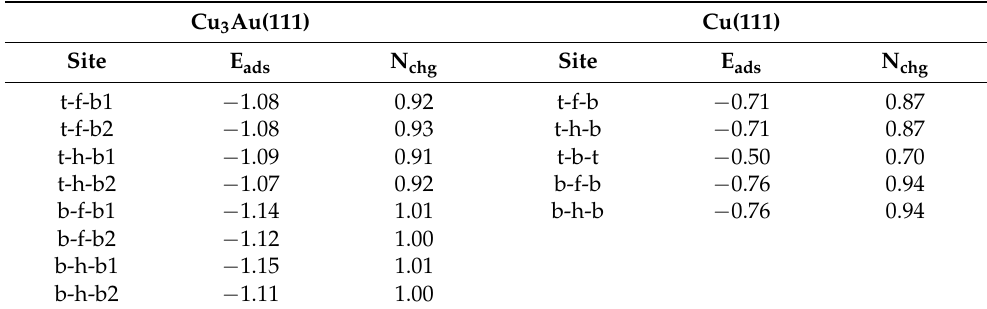
Figure 2. The top view for optimized configurations of O 2 adsorption on Cu-skin Cu 3 Au(111) surface. The two kinds of nonequivalent Cu atoms (Cu 1 and Cu 2 ) are marked in Figure 2a. The brick-red, gold, and red balls represent copper, gold, and oxygen atoms, respectively. For clarity, the topmost atoms on the surface are displayed with the biggest balls and only the top two layers are displayed. Table 1. The adsorption energy of O 2 (E ads in eV) and the number of electrons obtained by O 2 from the surfaces of Cu-skin Cu 3 Au(111) and